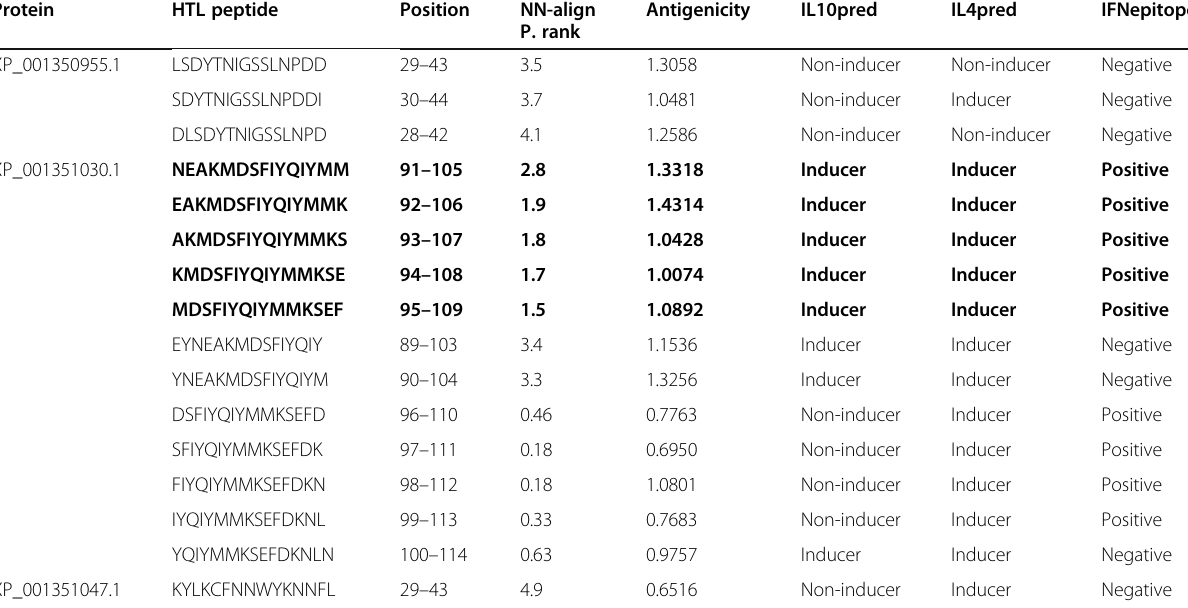
Antigenicity IL10pred IL4pred IFNepitope P. rank